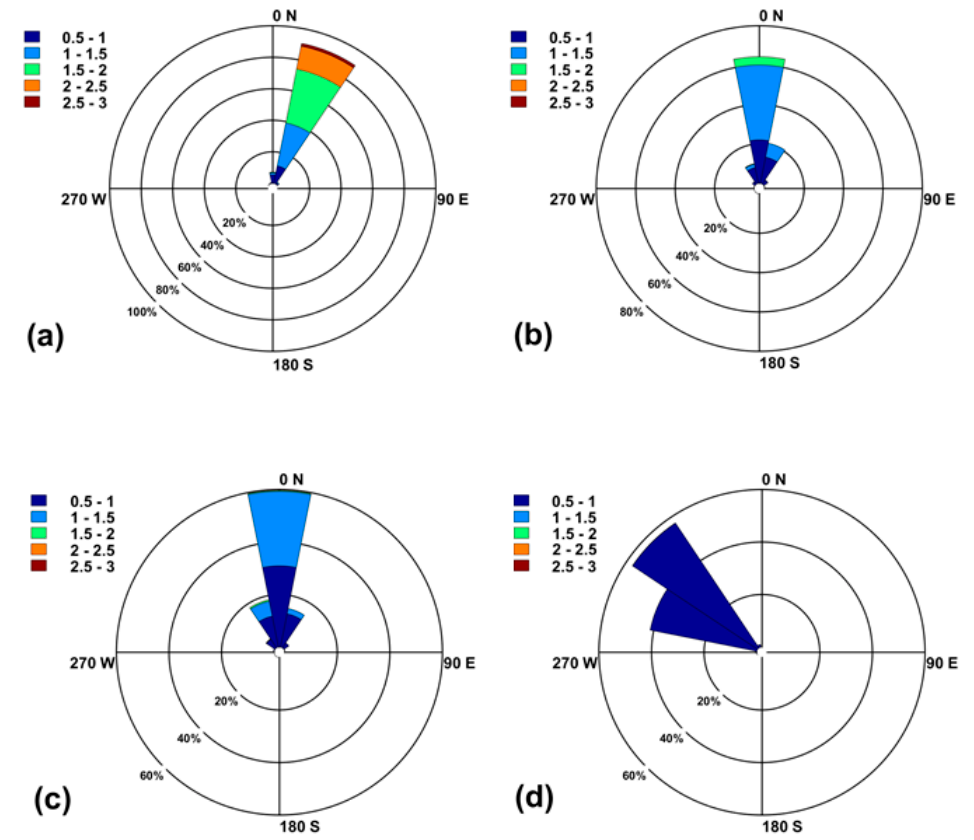
Figure 7. Significant wave height annual roses for Km 19 ( a ), Tasajera ( b ), Pueblo Viejo ( c ) and Ciénaga ( d ). Color scale in meters.